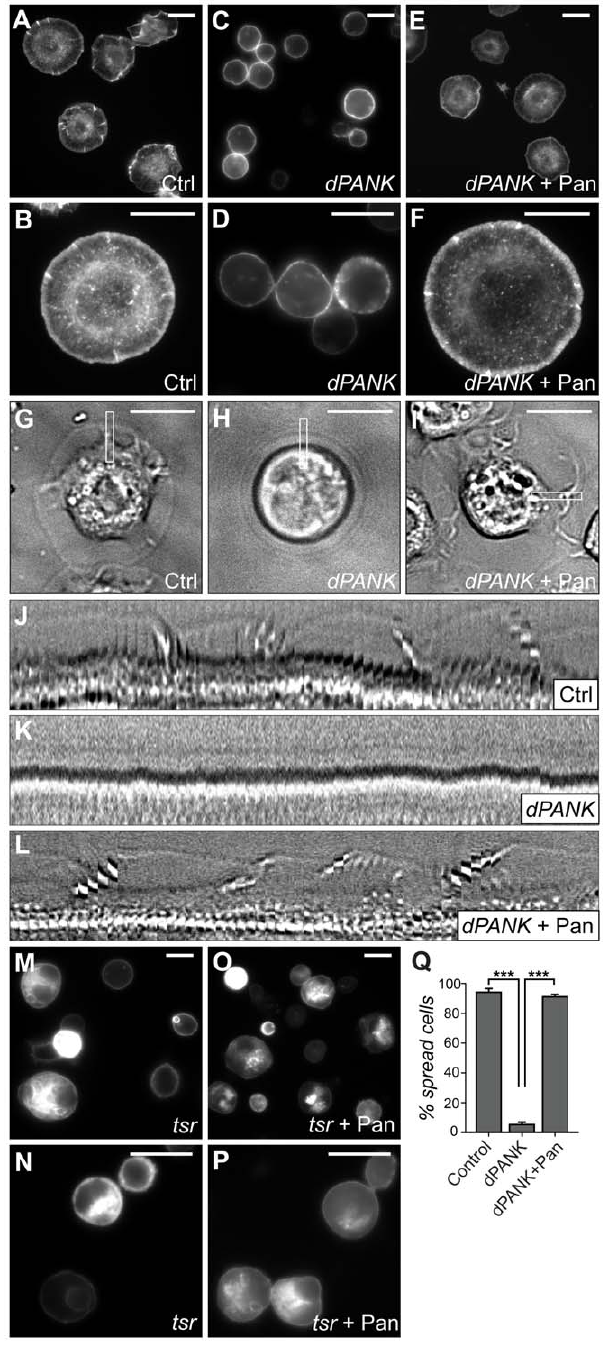
Figure 1. CoA deficient Drosophila S2 cells fail to form actin- based lamella. S2 cells were seeded on concanavalin A to induce cell spreading and lamella formation. Actin was visualized with rhodamine- phalloidin staining. ( A,B ) Representative images of the Ctrl; ( C,D ) dPANK/Fbl RNAi; ( E,F ) dPANK/Fbl RNAi treated cells supplemented with pantethine; ( M,N ) Twinstar RNAi; and ( O,P ) Twinstar (Tsr) RNAi treated cells supplemented with pantethine are shown. ( G–L ) S2 cells were seeded in concanavalin A coated glass bottom culture dishes and imaged during cell spreading and lamella formation in phase contrast with an inverted Zeiss confocal microscope using a 63 6 glycerol- immersion lens. Frames were acquired every 20 seconds for 20 min- utes. Individual images from Ctrl ( G ), dPANK/Fbl RNAi ( H ), dPANK/Fbl RNAi treated cells supplemented with pantethine ( I ) are shown.